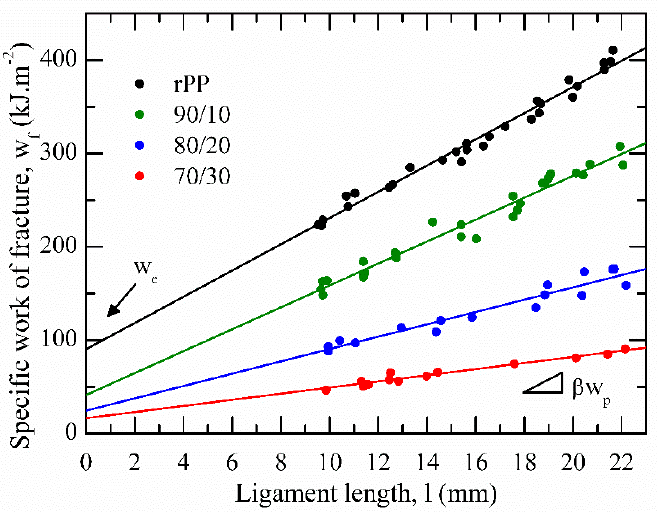
Table 4. Total EWF parameters of rPP/rPET-O calendered sheets tested at 10 mm·min − 1 . Sample Figure 11. Specific work of fracture as a function of the ligament length for the studied